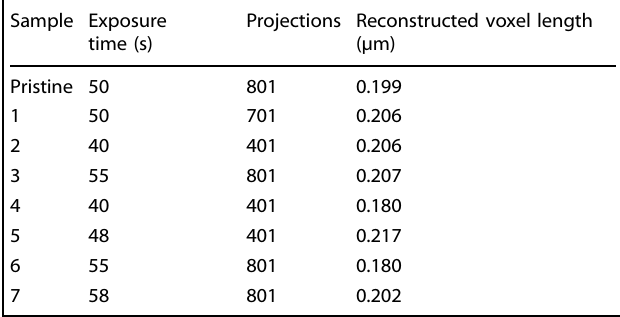
Table 5. X-ray imaging parameters for the seven